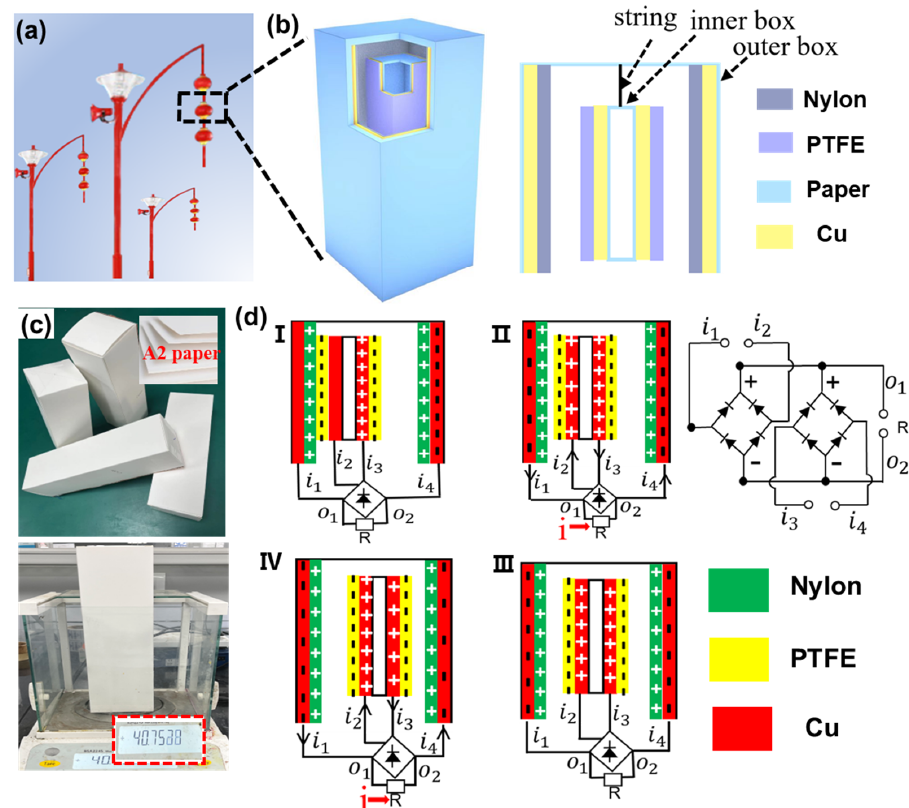
Figure 1. ( a ) Diagram of CS-TENG application scenarios. ( b ) Detailed structure of CS-TENG. ( c ) Photo images of the as–fabricated CS-TENG. ( d ) Schematic working process of CS-TENG. ( I – IV ) Charge distribution and current direction during the movement of the inner box from left to right. ( d-I ) The inner box is on the left. ( d-II ) The inner box is away from the left friction layer. ( d-III ) The inner box is in the middle position. ( d-IV ) The inner box is close to the right friction